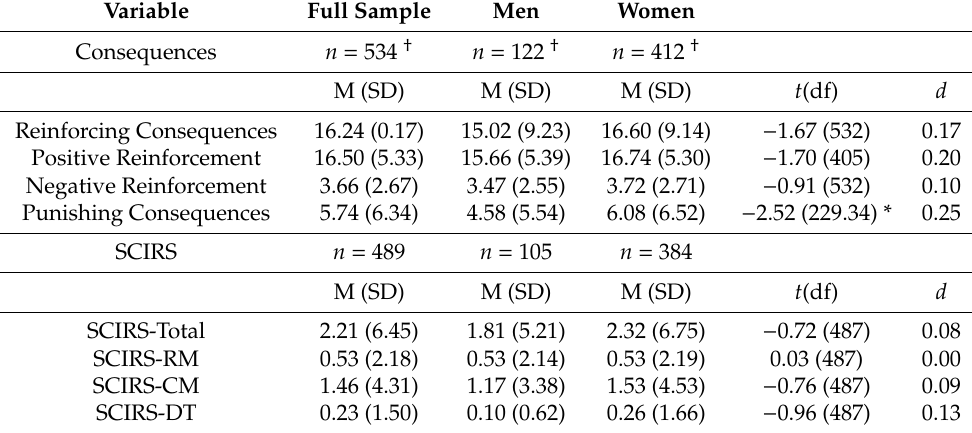
Table 1. Gender di ff erences in sexting consequences and sexual coercion. Variable Full Sample Men